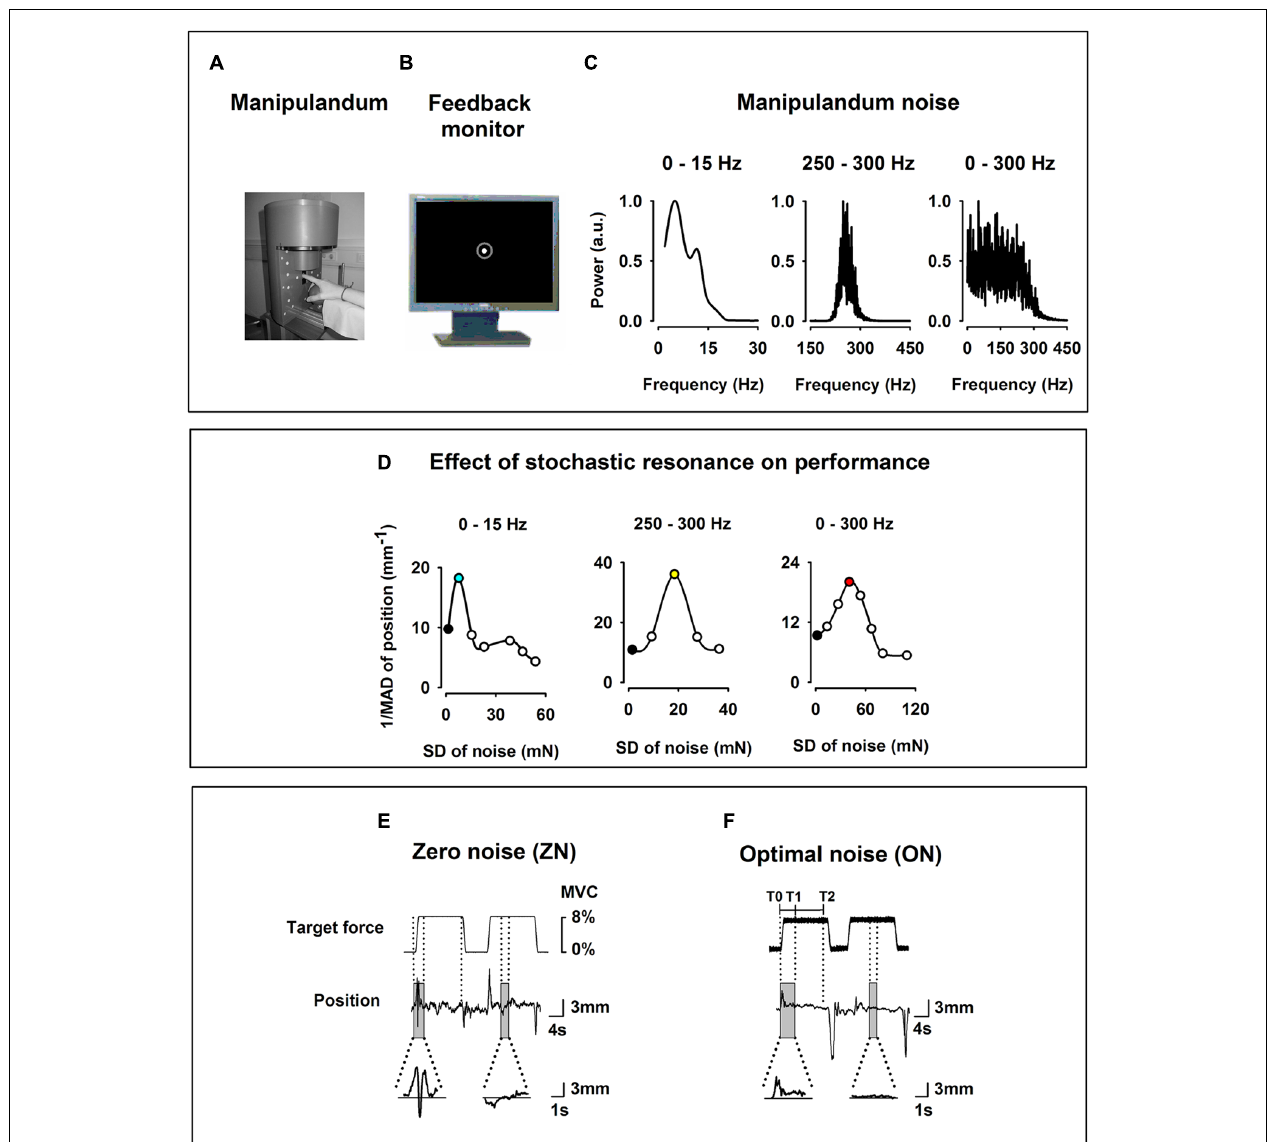
computed as the inverse of the mean absolute deviation of the finger position. Note the inverted U-shape like curve for all three bandwidths. During the experimental session only two noise levels were individually chosen, i.e., zero noise (ZN, black filled dots) and optimal noise (ON, filled dots for 0–15 Hz in turquoise for 0–15 Hz, in yellow for 250–300 Hz, and pink for 0–300 Hz). (E,F) Original curves for target force and finger position (representing the exerted force) for ZN (E) and ON (F) for the frequency bandwidth noise 0–300 Hz.Transitory phase of the task between markersT0 andT1 and stationary phase between markersT1 andT2. Note in the magnified position traces the better performance for ON than for